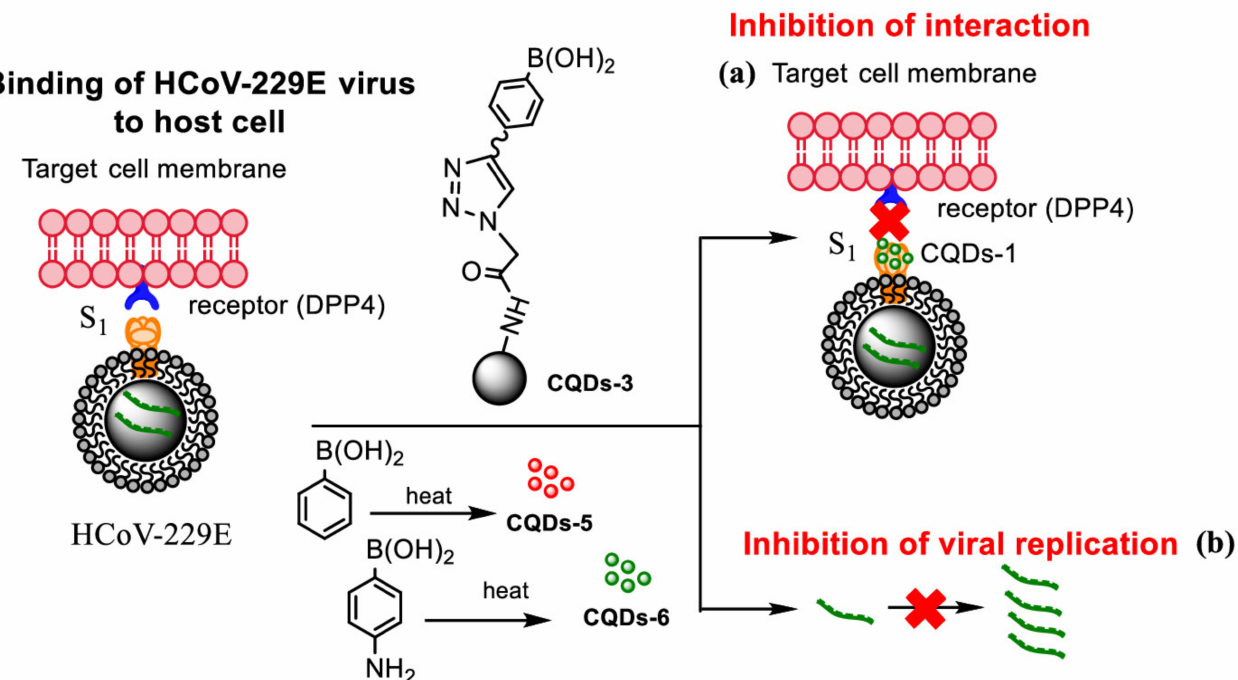
Figure 15. Proposed mechanisms for viral replication inhibition of HCoV-229E-Luc infection by CQDs, through the interference with protein S receptor interaction (a) and by the inhibitory influence on the replication of viral RNA genome. Reproduced with permission from ref. [193], published by American Chemical Society,